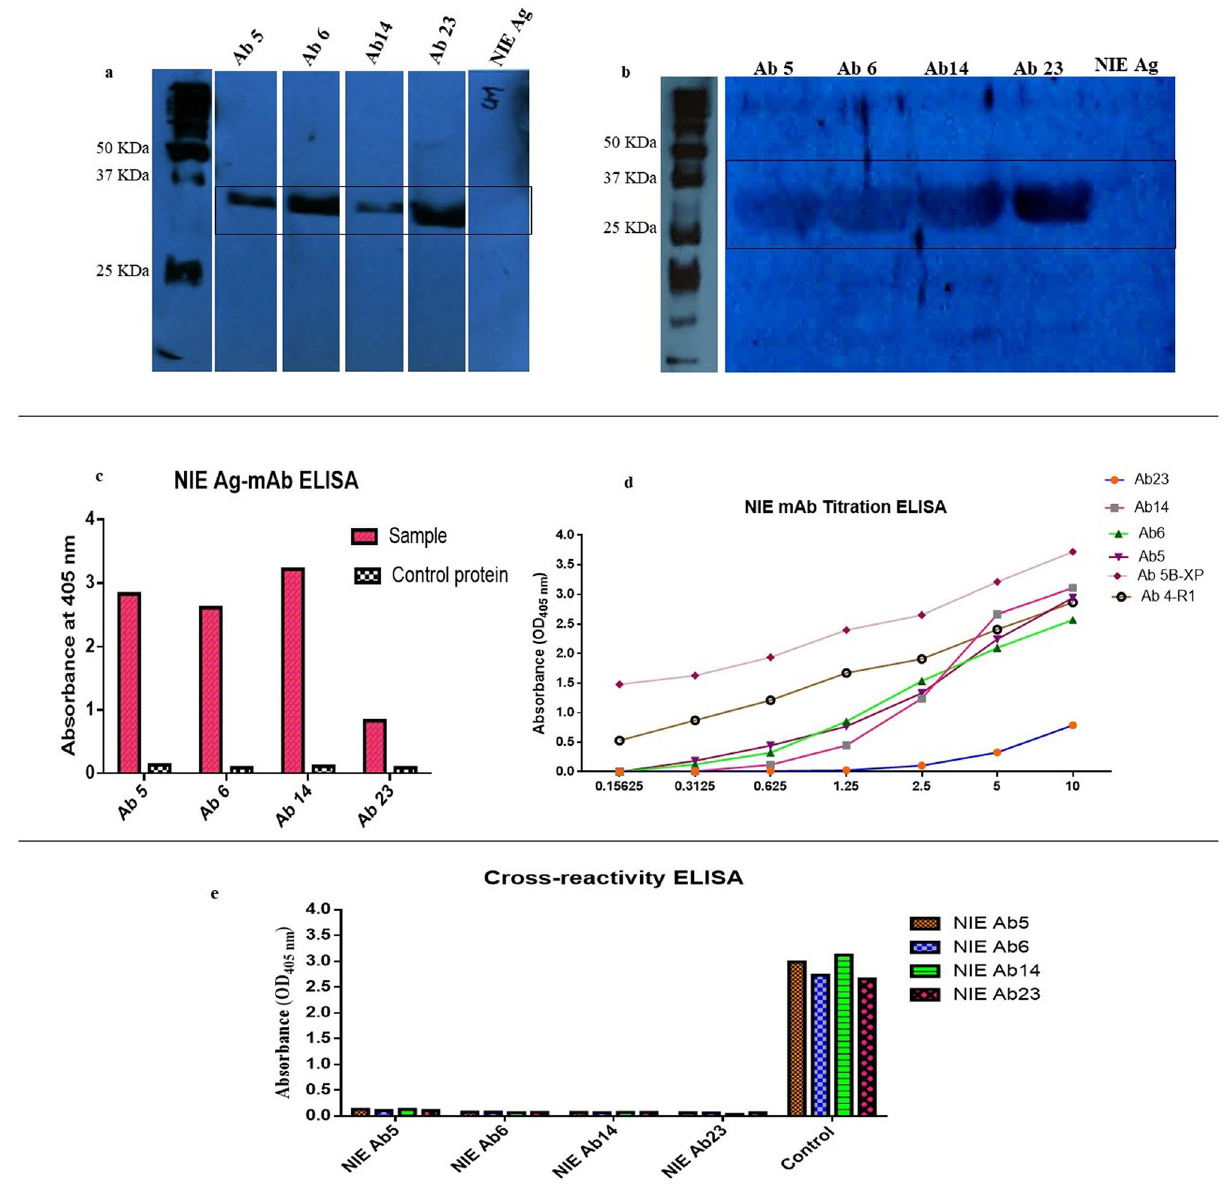
Figure 7. Verification and binding analysis of rNIE specific recombinant monoclonal antibody proteins. ( a ) Western blot analysis of recombinant monoclonal antibody proteins. ( b ) Antigen–antibody Western blot analysis. ( c ) Immunoassay analysis of recombinant monoclonal antibody proteins. ( d ) Antibody titration ELISA; Ab23, Ab14, Ab6, Ab5 are antibody clones against rNIE, Ab5B-XP and Ab4-R1 are antibody clones against BmSXP and BmR1 antigens respectively ( e ) Cross-reactivity ELISA. All the binding verifications were detected using Strep Tactin HRP conjugated antibody except for cross-reactivity ELISA was detected using anti-M13 HRP conjugated